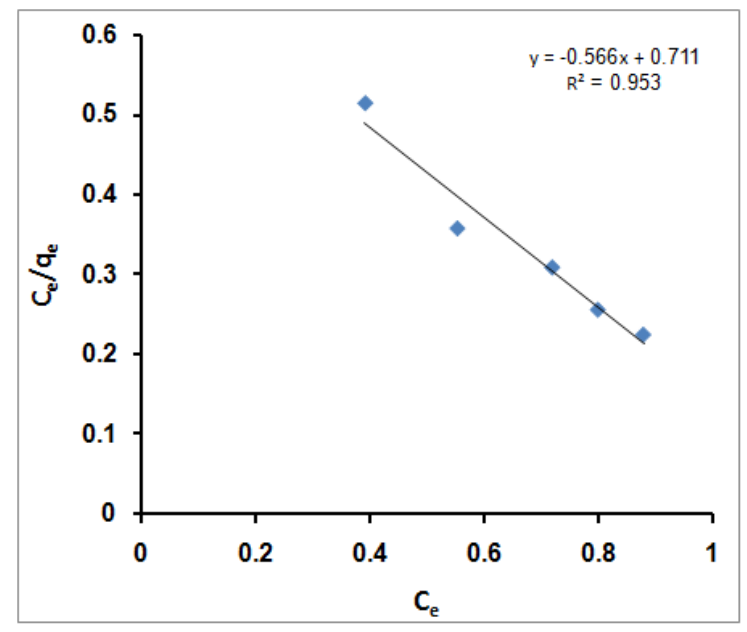
Figure 3. Langmuir isotherm for MB adsorption using SPGMA.